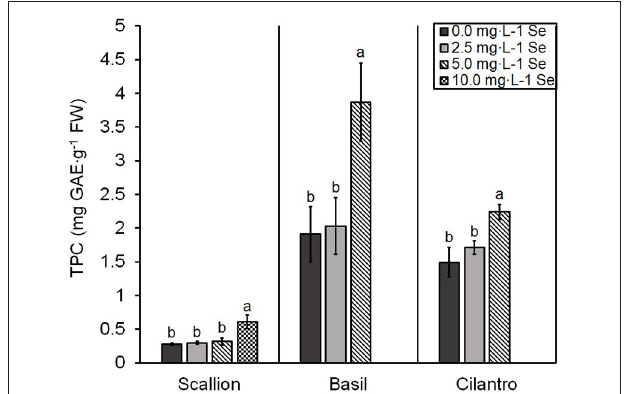
FIGURE 4 | Total phenolic content (TPC) of scallion ( Allium fistulosum L.), basil ( Ocimum basilicum L.), and cilantro ( Coriandrum sativum L.) microgreens treated with various concentrations of selenium (Se) as sodium selenate on a fresh weight (FW) basis. Bars indicate mean ± standard deviation (SD) for three replicates ( n = 3) of each plant species. The Tukey’s significance at P ≤ 0.05 among Se treatments is indicated by different letters within the plant species.